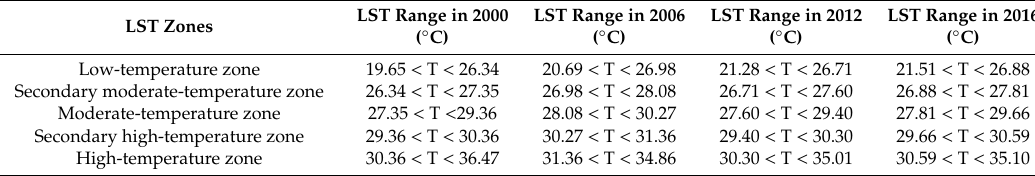
Table 3. Classification results for surface temperature in 2000, 2006, 2012 and